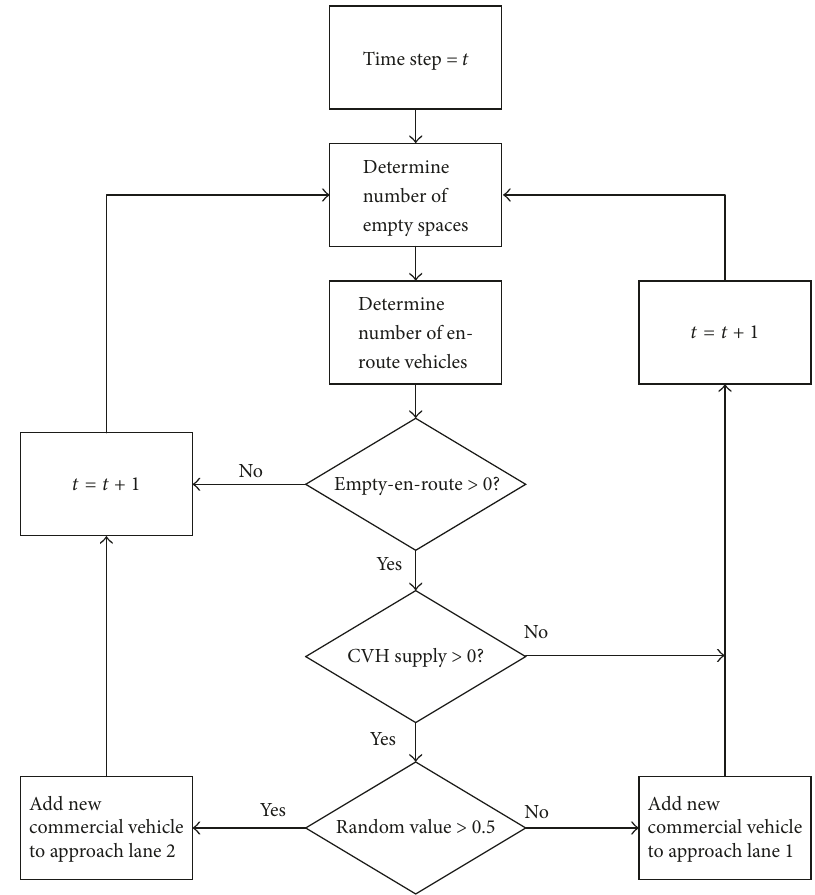
Figure 2: Algorithm for generating new taxis and